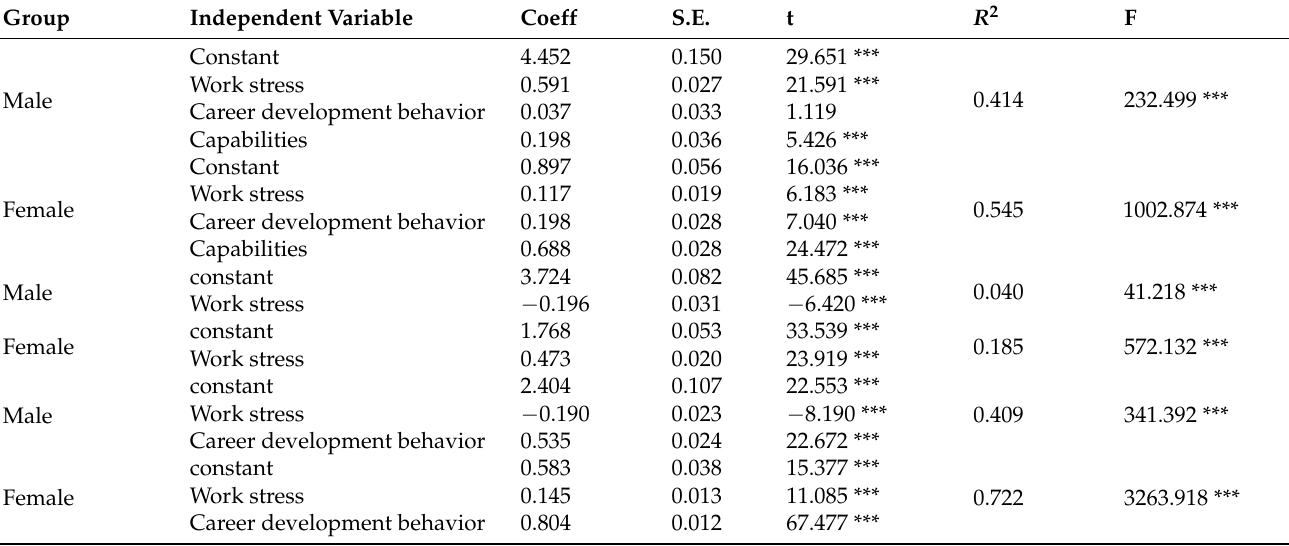
Table 1. Effect of work stress and career development behavior and capabilities on turnover intention.